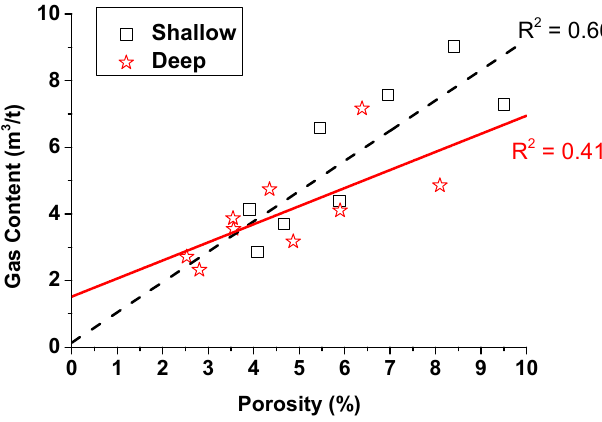
Figure 9. Relationship between gas content and porosity.